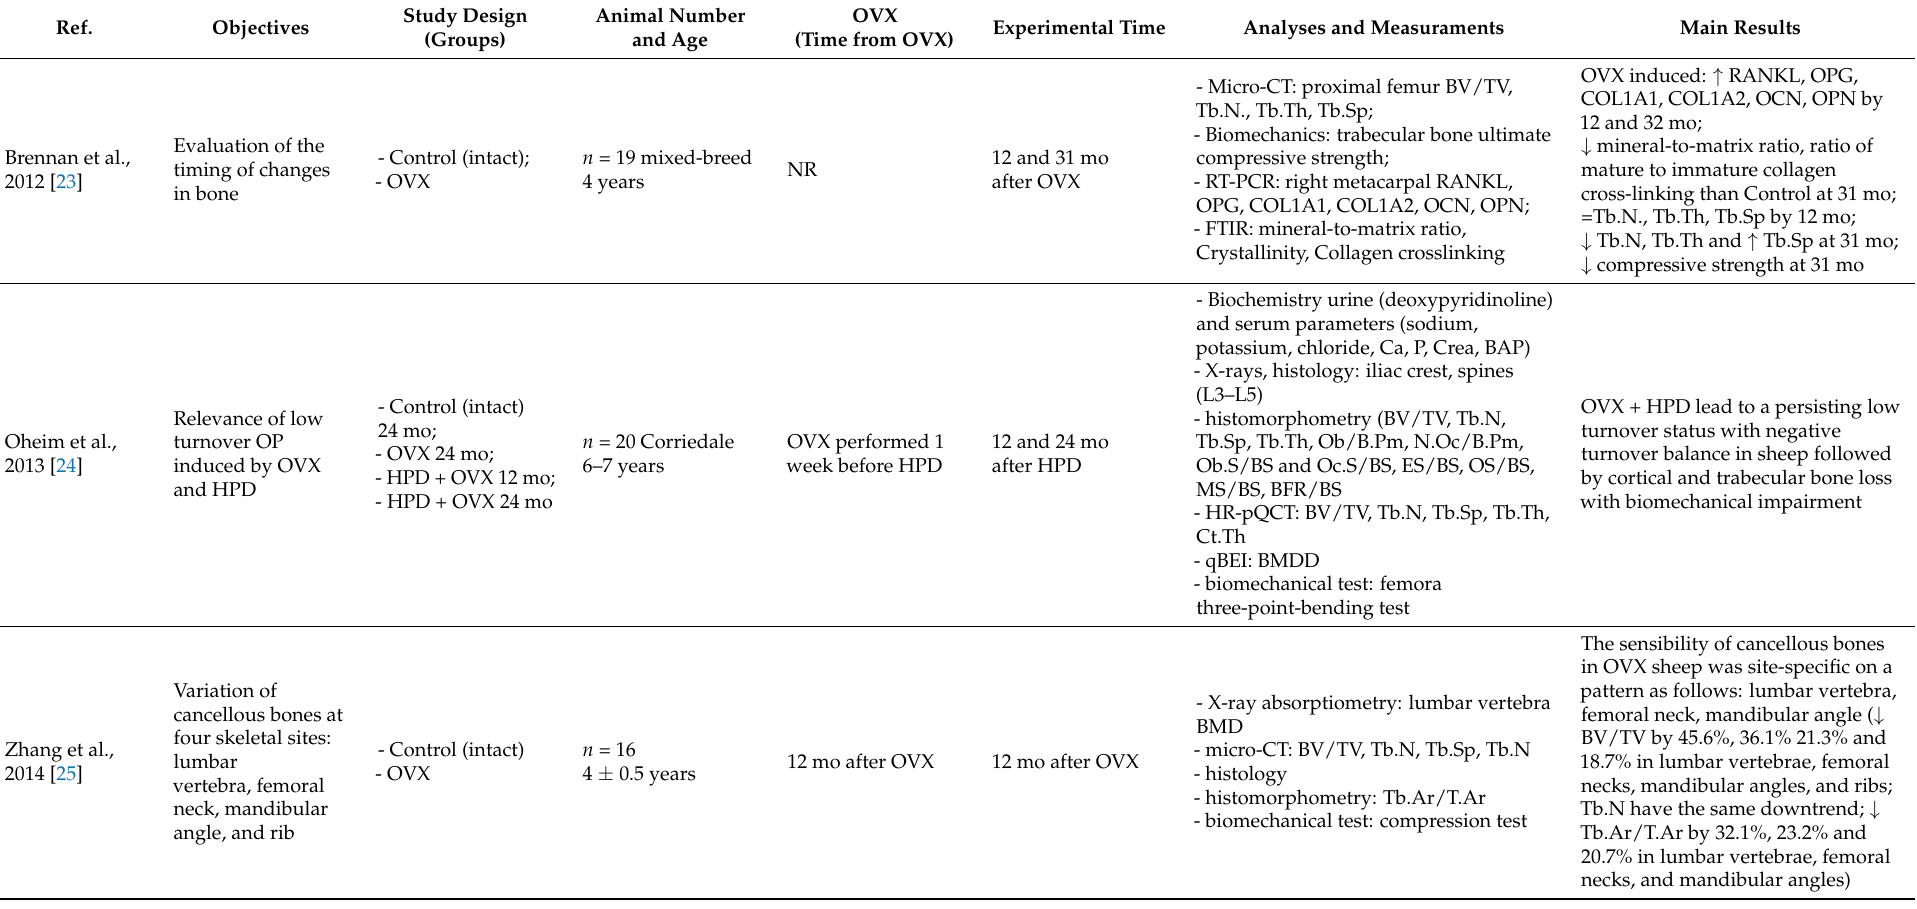
Table 2. Studies’